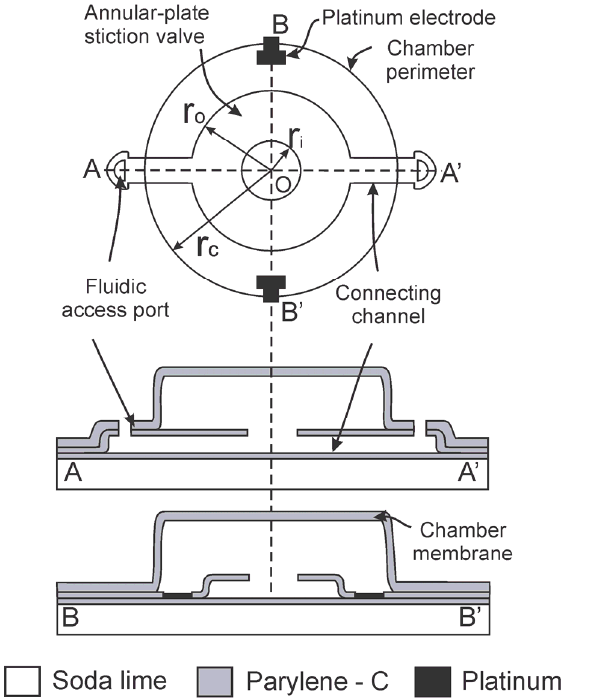
Figure 1. ( Top ): Top-view of device footprint with key radii indicated. ( Middle ): Cross-section taken through connecting channel and fluidic access ports. ( Bottom ): Cross-section through electrodes.